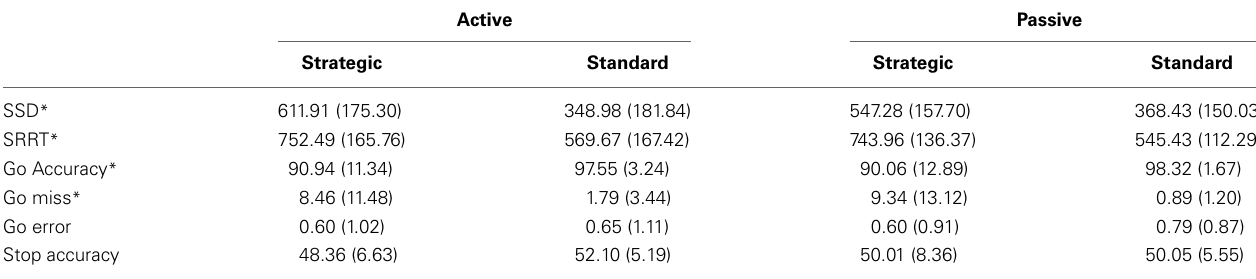
Table 2 | Stop signal task variables.